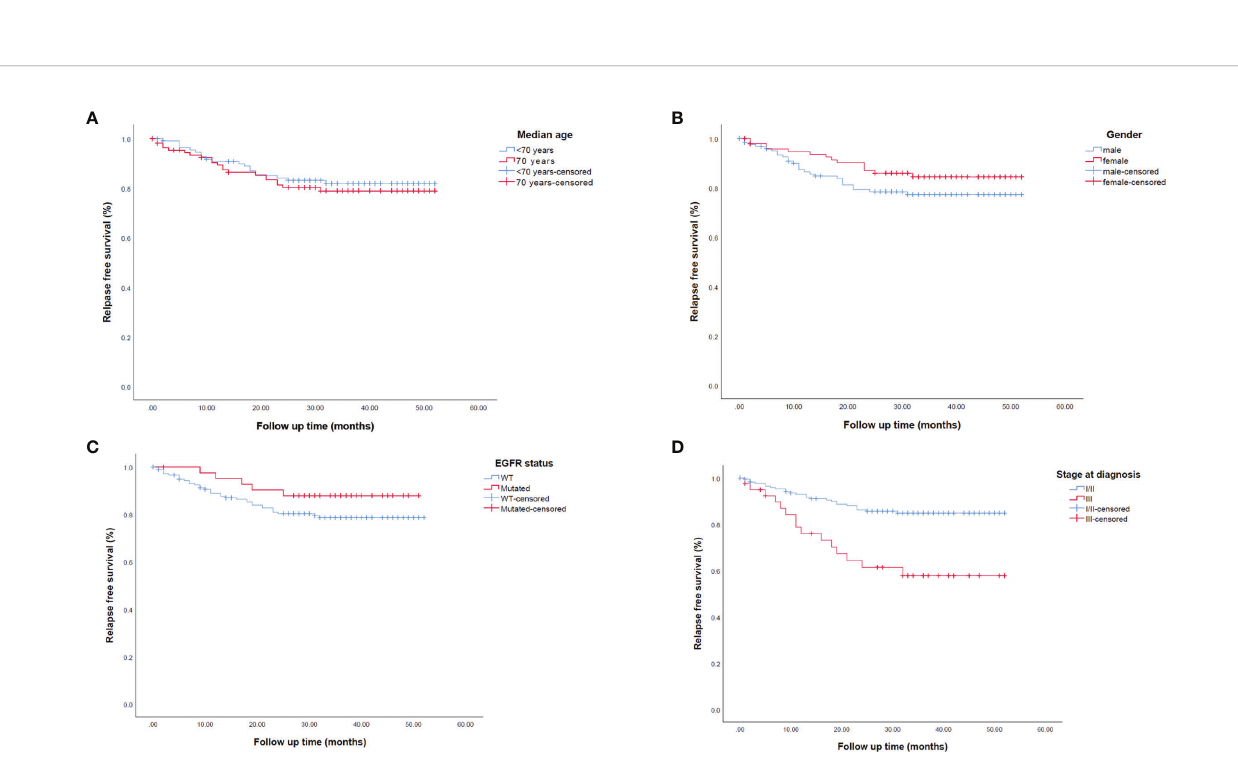
FIGURE 4 | Kaplan-Meier survival curves representing median relapse-free survival (mRFS) in early-stage resected NSCLC patients according to (A) median age, (B) gender, (C) EGFR status and (D) stage at diagnosis. EGFR, epidermal growth factor receptor; WT, wild-type.